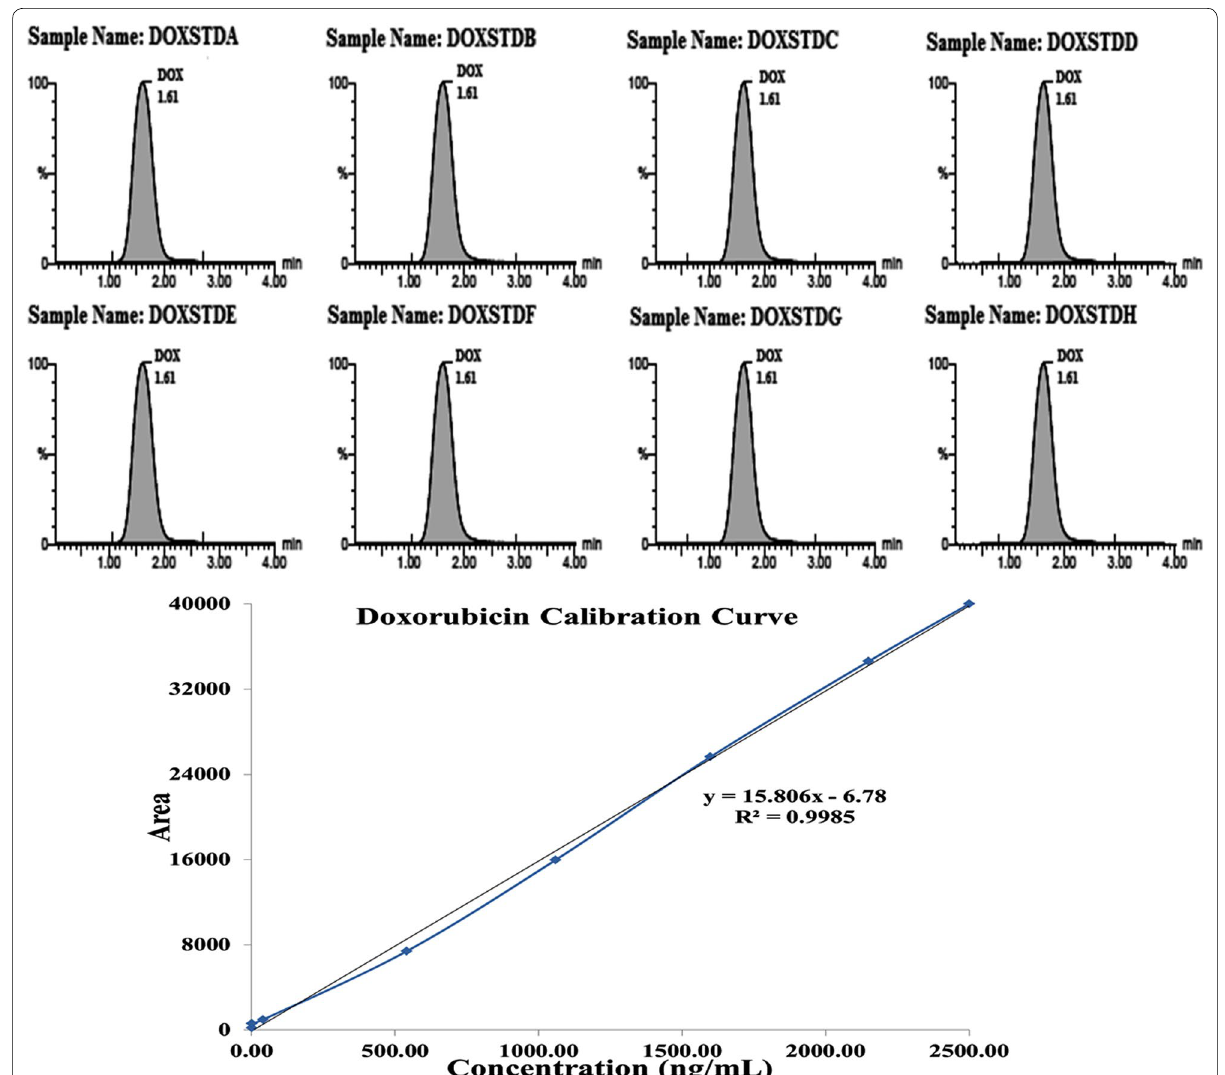
Fig. 7 Calibration standard peaks at different calibration standards 1.0, 2.0, 40.0, 540.0, 1060.0, 1600, 2150, and 2500.0 ng/ml with their calibration graph (1.0–2500.0 ng/ml)